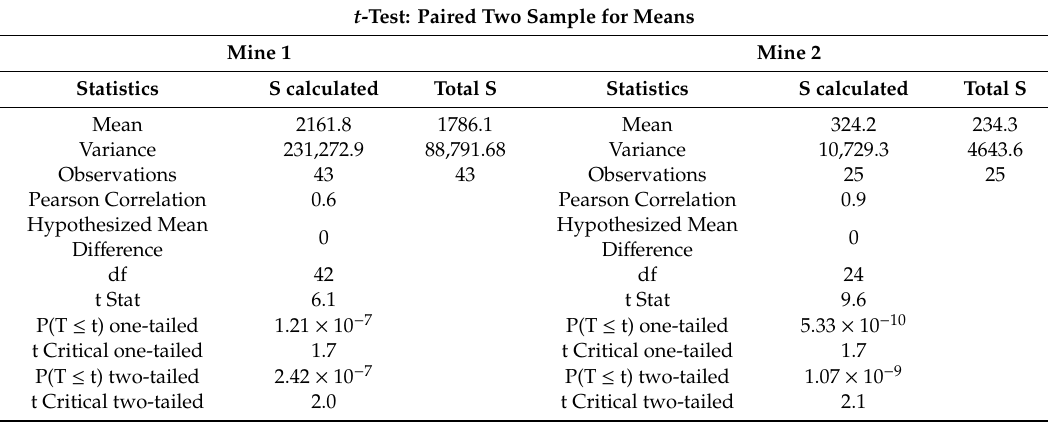
Table A3. The t -test results for comparing S calculated from S compounds and total S. t -Test: Paired Two Sample for Means